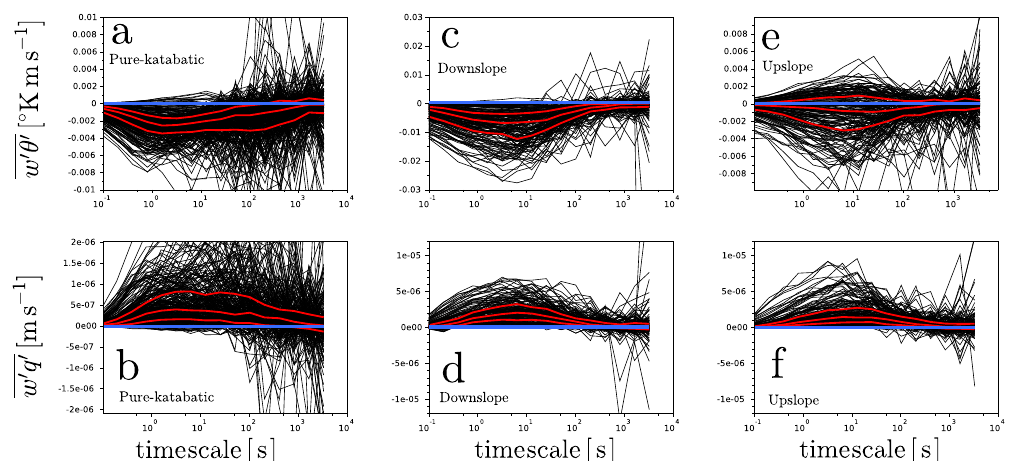
Figure 5. Multi-resolution decomposition (MRD) cospectra (black lines) of w with θ (upper panels, a , c and e ) and of w with q (lower panels b , d and f ) from individual runs of “pure-katabatic” (left, a and b ), “downslope” (centre, c and d ) and “upslope” (right, e and f ) wind-regime subsets. Quantiles 25, 50 and 75 of the cospectra at each dyadic timescale calculated over a subset (red curves) and the zero line (blue line) are plotted.